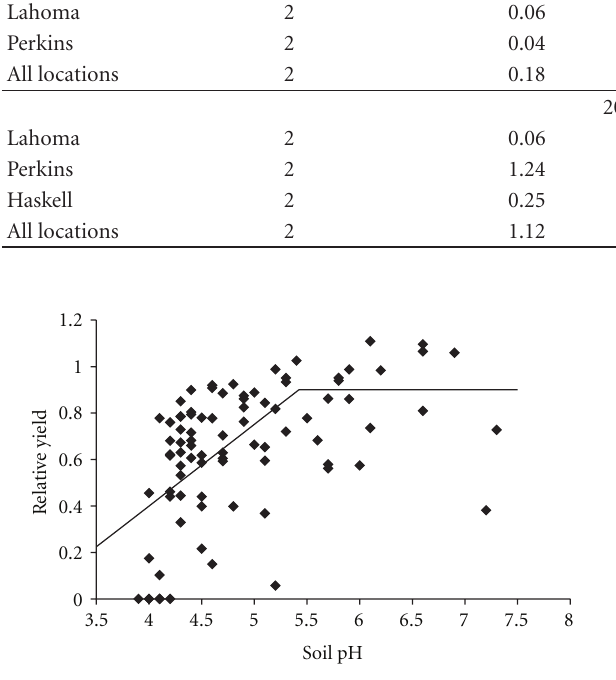
Figure 6: Quadratic relationship of potassium-chloride-extractable Al concentration in soil and grain sorghum relative yield at Perkins, Lahoma, and Haskell, Oklahoma